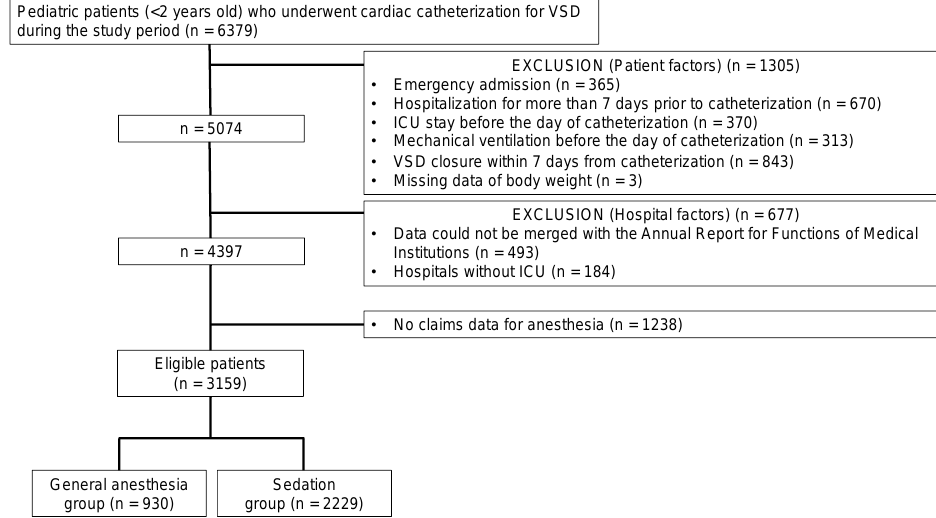
Figure 1. Patient selection flowchart. VSD, ventricular septal defect; ICU, intensive care unit.